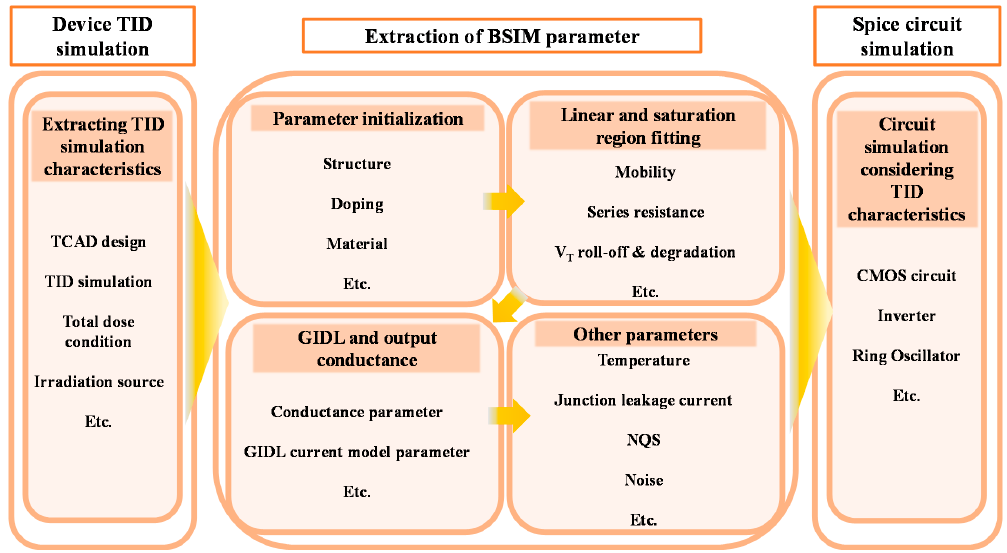
Figure 4. Flow chart of the simulations considering the TID